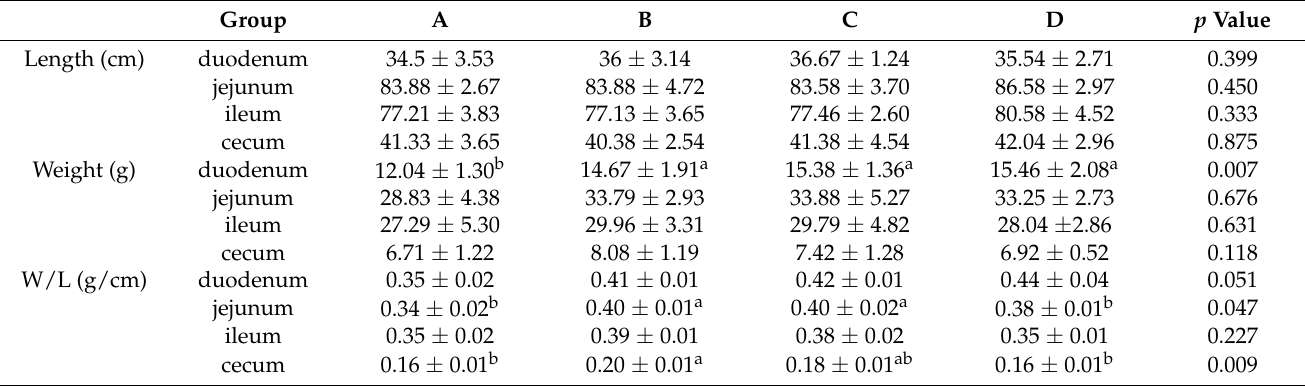
Table 3. Effects of probiotics supplementation on the absolute lengths and weights of different intestinal segments in the geese at the age of 70